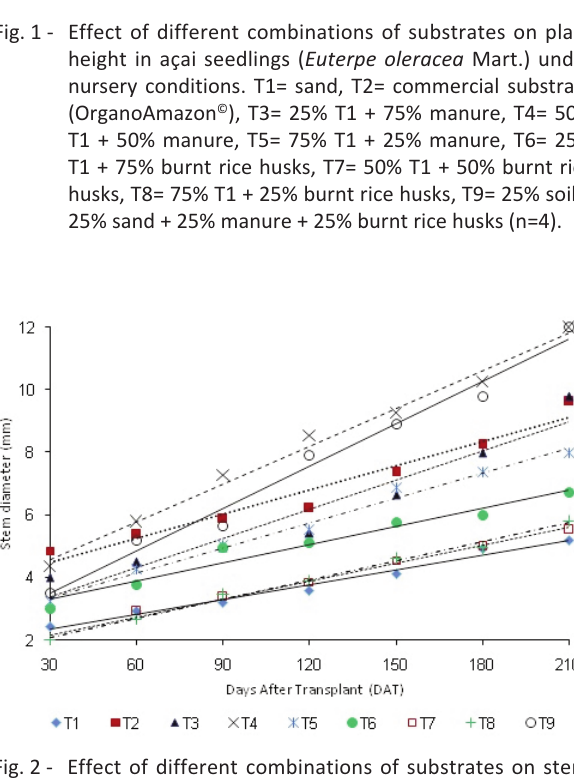
Fig. 2 ­ Effect of different combinations of substrates on stem diameter in açai seedlings ( Euterpe oleracea Mart.) under nursery conditions. T1= sand, T2= commercial substrate (OrganoAmazon © ), T3= 25% T1 + 75% manure,